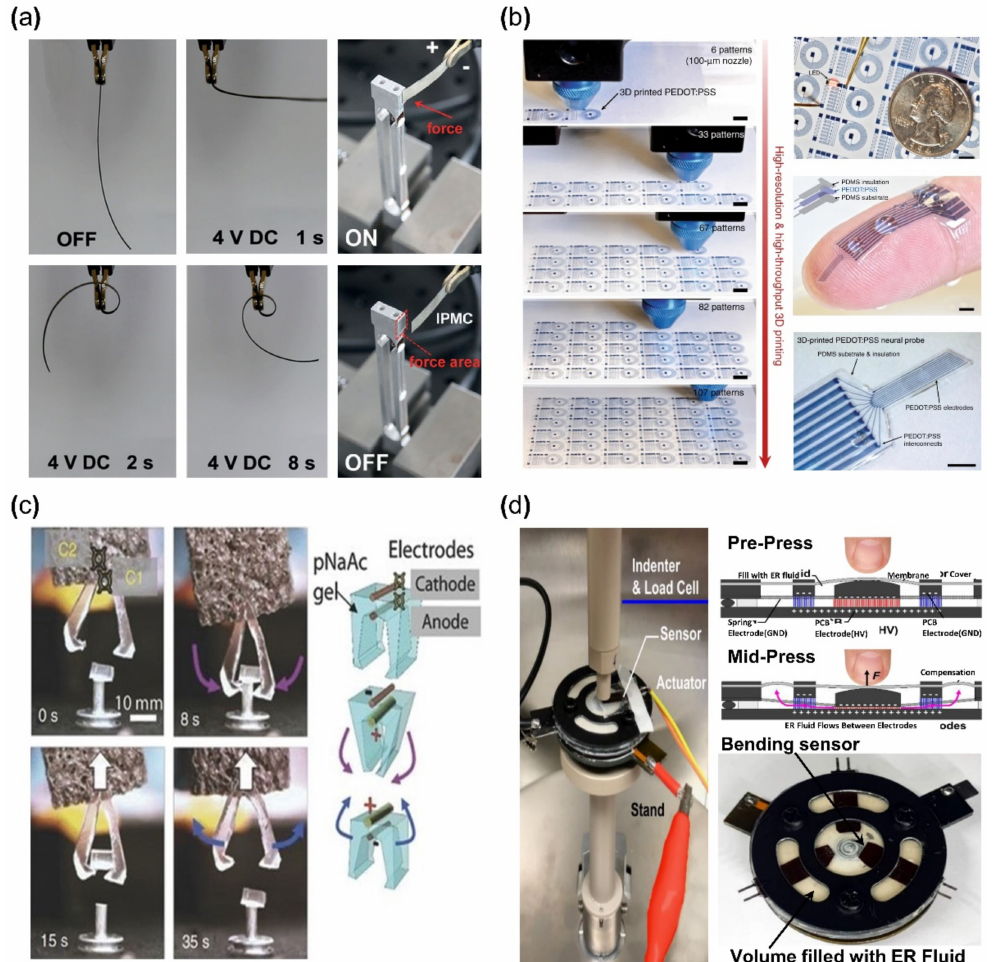
Figure 4. Application examples of ionic EAP devices. ( a ) Bending actuator; bending aspect of IPMC (left) and force measurement method of IPMC (right). Adapted from Ma et al. [30] with permission from Wiley-VCH Verlag GmbH, Copyright (2019). ( b ) Demonstration of basic circuit 3D printed with PEDOT: PSS. Adapted from Yuk et al. [45] with permission from Nature Portfolio, Copyright (2020). ( c ) Mechanical tweezer constructed from ionic gel. Adapted from Palleau et al. [46] with permission from Nature Portfolio., Copyright (2013). ( d ) Haptic actuator module made from electrorheological fluids. Adapted from Mazursky et al. [47] with permission from MDPI, Copyright